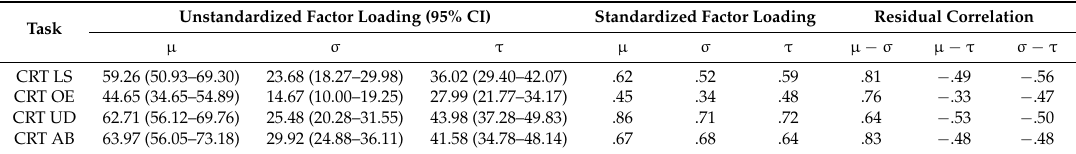
Table 2. Factor loadings and residual correlations from the confirmatory factor analysis with the ex-Gaussian parameters.